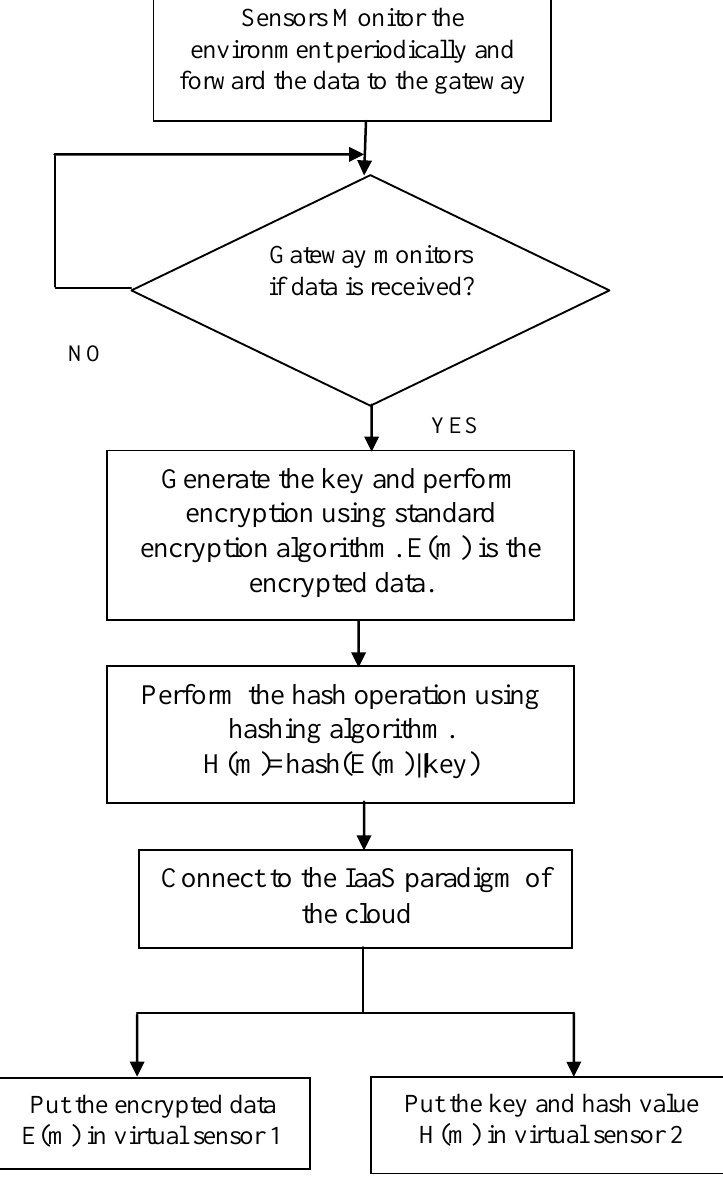
Figure 5. Phase – I Gateway outsourcing the data into the cloud after performing encryption and hashing